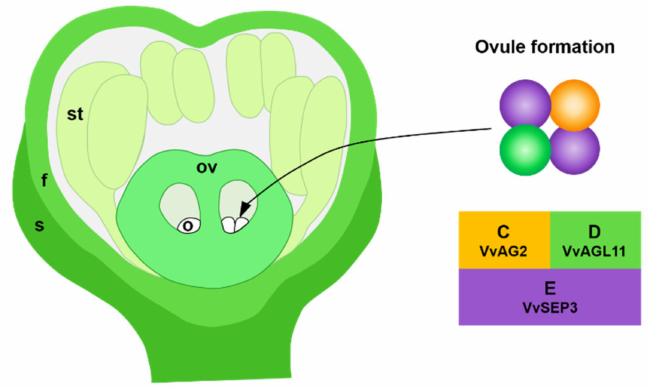
Figure 9. Diagram: VvAG2/VvSEP3 and VvAGL11/VvSEP3 form tetramers and participate in the formation of ovules. The orange sphere represents VvAG2 protein; the purple sphere represents VvSEP3; the green sphere represents VvAGL11. o, ovule primordia; s, sepal primordia; f, flower cap primordia; st, stamen primordia; ov,